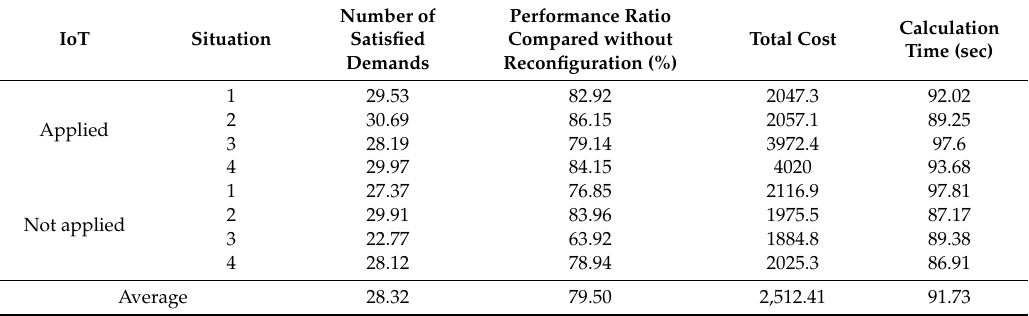
Table 7. Experimental result according to IoT application and reconfigurable